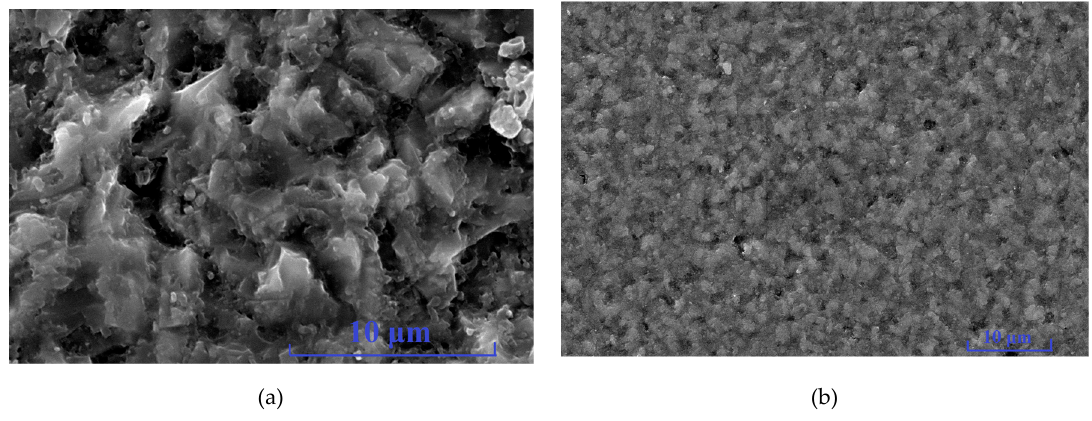
Figure 9. Morphology of single crystal 6H-SiC substrates after lapping. ( a ) After lapping by W14 diamond. ( b ) After lapping by W1.5 diamond.